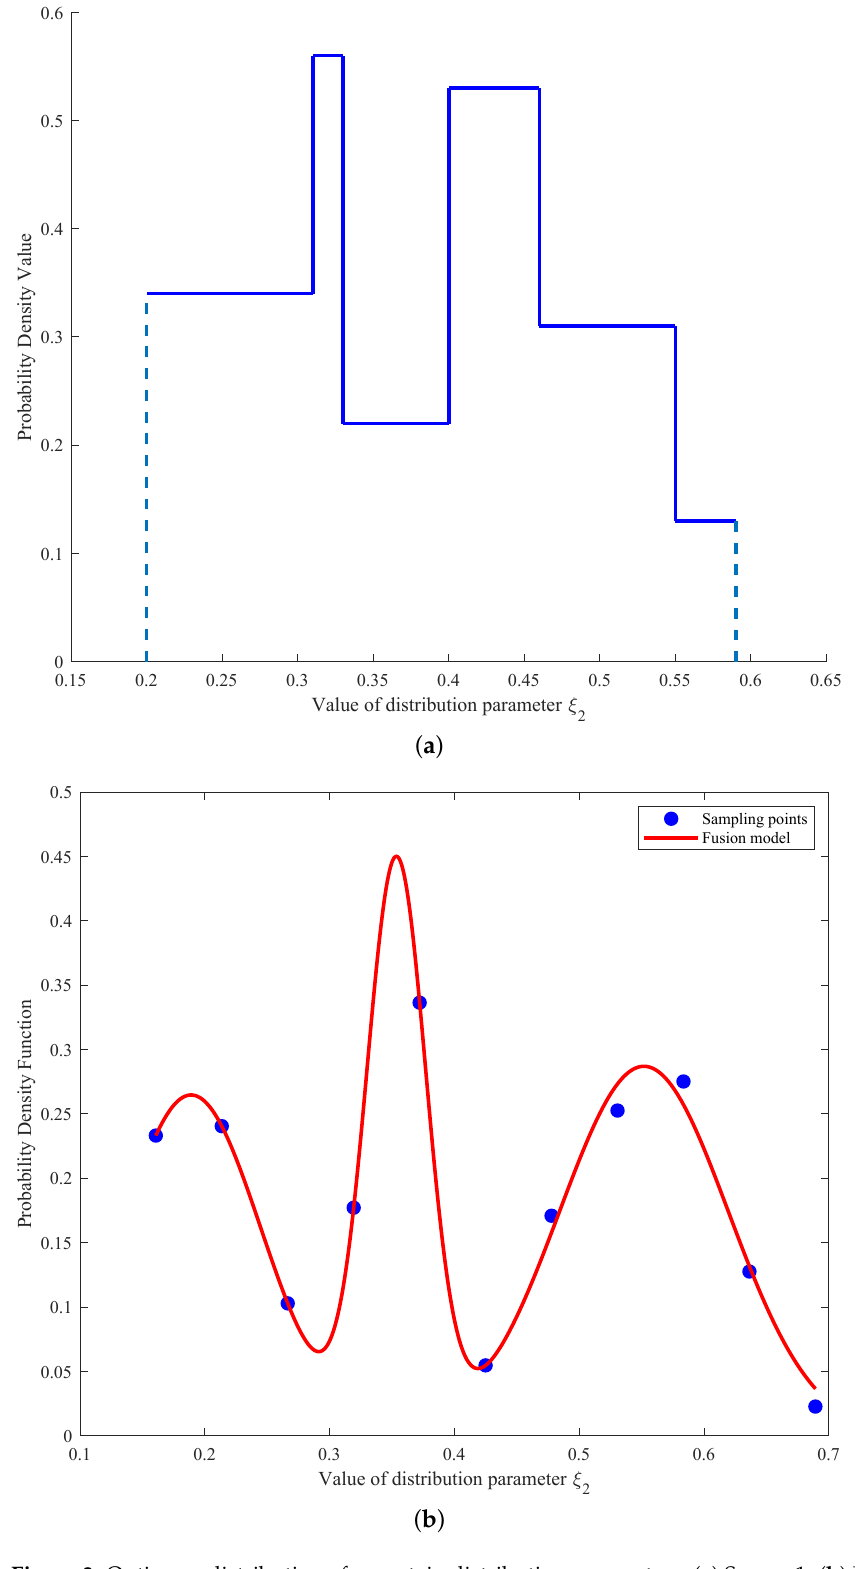
Figure 3. Optimum distribution of uncertain distribution parameters: ( a ) Source 1. ( b ) Fusion